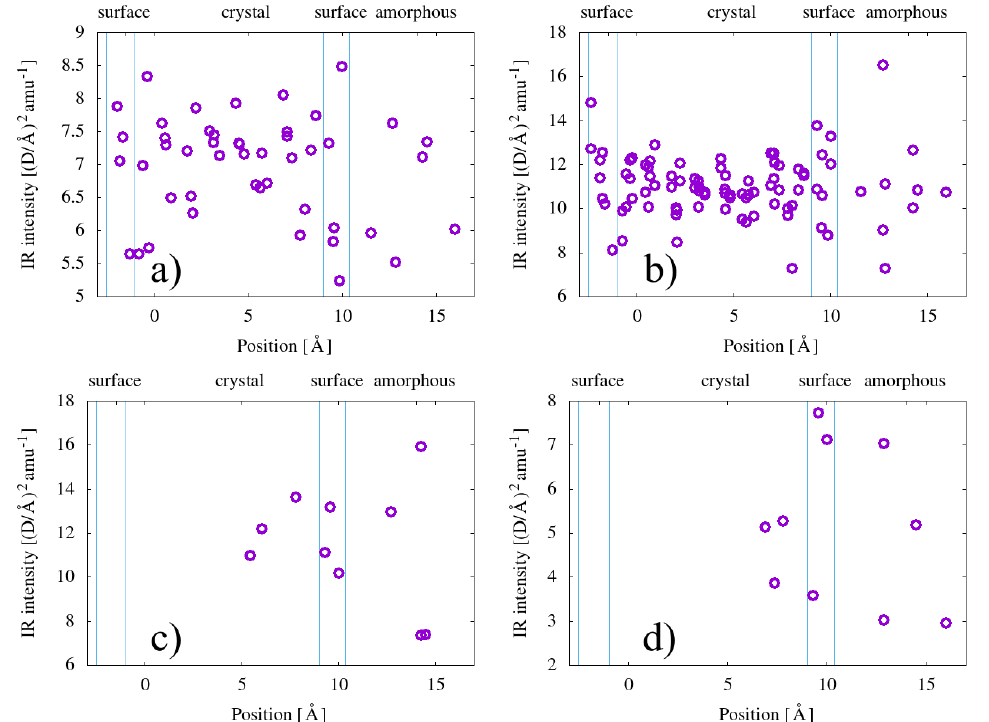
Figure 6. Calculated infrared activities of the carbonyl group for ( a ) ketones, ( b ) esters, ( c ) carboxylic acids, and ( d ) enones, presented as a function of the position in the simulation cell in the direction perpendicular to the lamellae. Vertical blue lines delimit regions identified as amorphous, crystalline, and surface, as shown on top of the